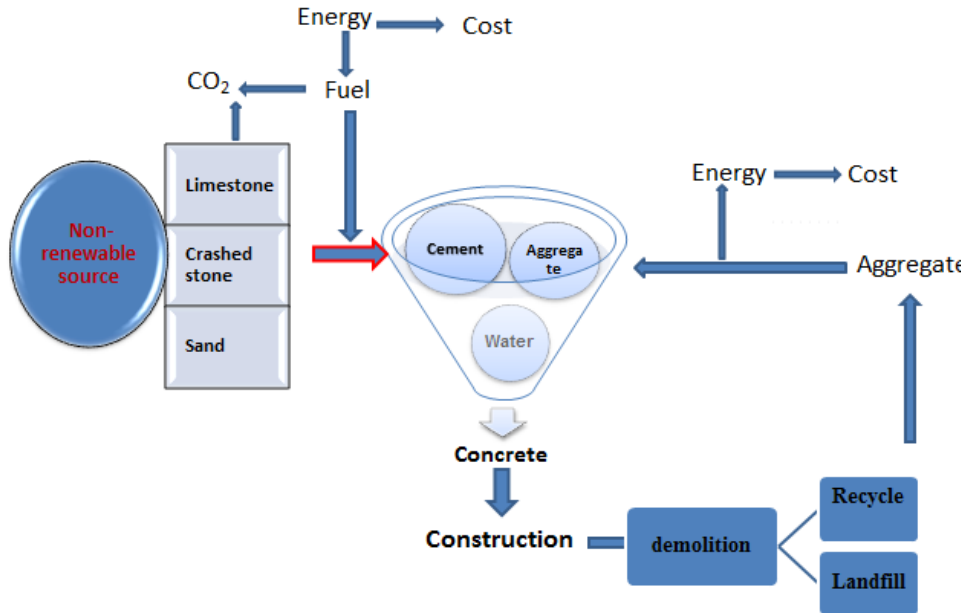
Figure 1. Renewable cycle of recycled concrete aggregates (RCAs).